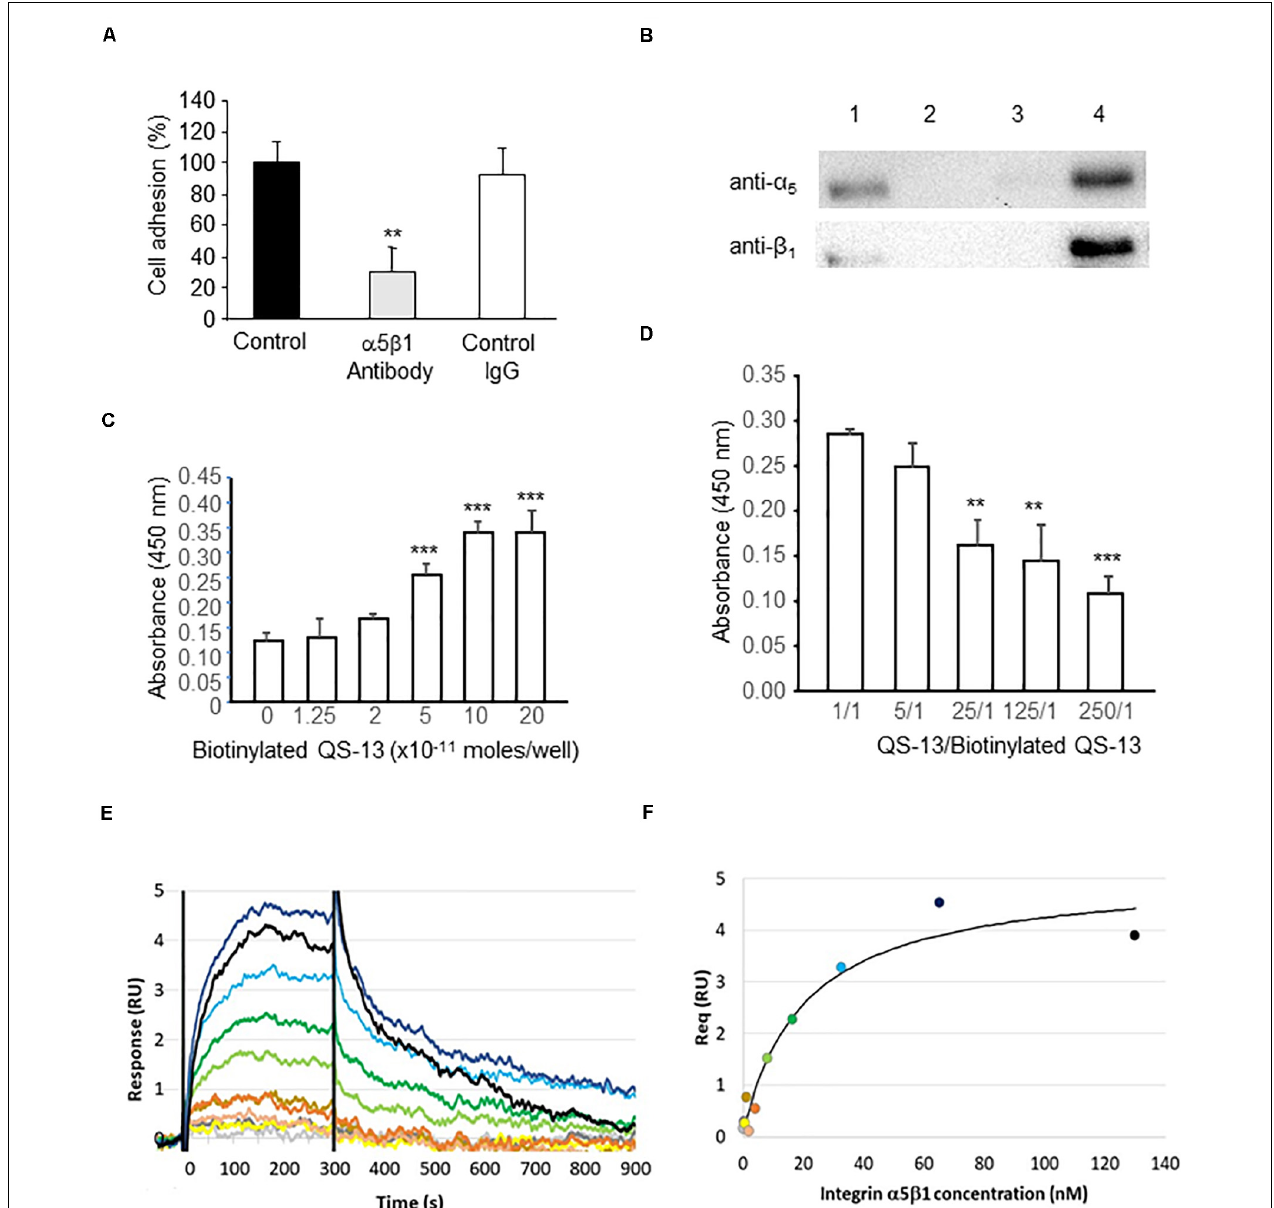
FIGURE 4 | QS-13 peptide binds to α 5 β 1 integrin. (A) HUVECs were pre-incubated with ECGM alone, ECGM containing an anti- α 5 β 1 blocking antibody or an irrelevant antibody (10 µ g/mL). HUVEC adhesion was measured as described in the section “Materials and Methods.” Three independent experiments were carried out. The histogram represents the means ± SD of the more representative one ( n = 8), ** p < 0.01. (B) HUVEC extracts were submitted to affinity chromatography on a QS-13 -bound column. Lane 1: total cell extracts; lane 2: unbound proteins; lane 3: 0.15 M NaCl eluted fraction; lane 4: 0.6 M NaCl eluted fraction. (C) Direct interaction between α 5 β 1 integrin at concentrations ranging from 0.25 to 2.10 - 10 mole/well and QS-13 was studied using solid phase assay as described in the “Materials and Methods” section. Two independent experiments were carried out ( n = 4), *** p < 0.001. (D) A competition assay was performed using increasing concentrations of unbiotinylated-QS-13 while biotinylated QS-13 and α 5 β 1 integrin concentrations were kept constant Two independent experiments were carried out ( n = 4), ** p < 0.01, *** p < 0.001. (E,F) The equilibrium affinity of the α 5 β 1 integrin-QS-13 interaction was analyzed by SPR. (E) Concentration-dependent responses of integrin α 5 β 1 (0.12 to 130 nM range) to the streptavidin-captured biotinylated QS-13. (F) Fit of the equilibrium response (Req) versus [ α 5 β 1 integrin] to a 1:1 binding indicates a K D of 20.3 ± 7.5 nM.